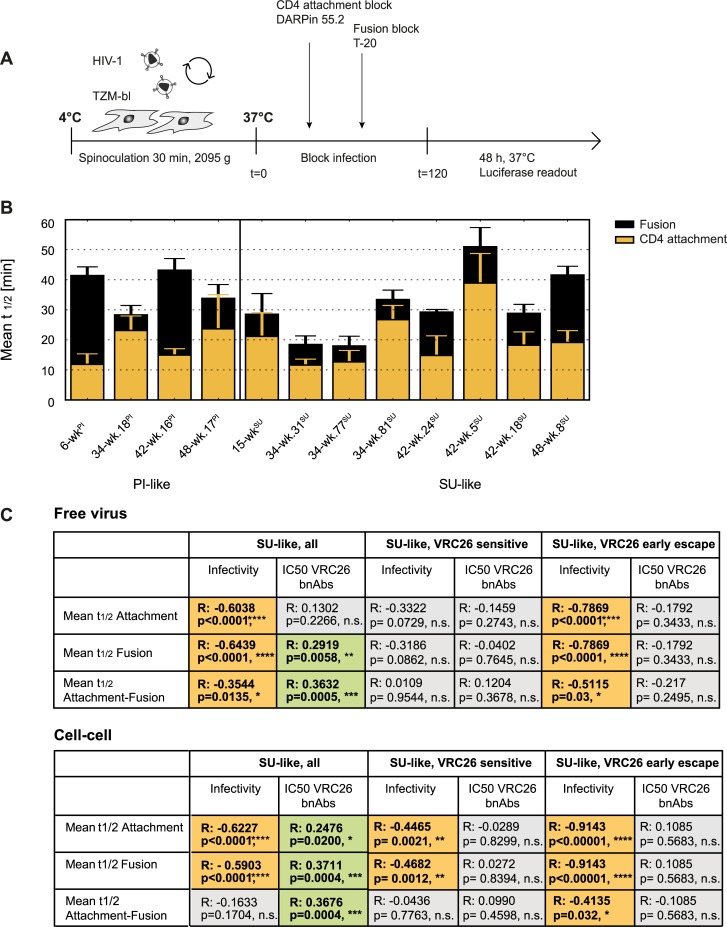
Virus evolution alters the entry kinetics of autologous CAP256 viruses.A: Schematic presentation of the free virus entry kinetic assay on TZM-bl target cells testing the half-maximal time to CD4-attachment and fusion. B: Mean half-maximal times of infection (t1/2) to CD4 attachment (orange) and virus fusion (black) of 2 to 4 independent experiments are displayed. C: Interrelations of IC50s (in μg/ml) for VRC26 bnAb neutralization, viral infectivity and mean half-maximal time (t1/2) to CD4-attachment, fusion and from CD4 attachment to fusion were determined for viruses analyzed in Fig 6B and displayed for all SU-like, SU-like VRC26 sensitive and SU-like VRC26 early escape viruses for both free virus and cell-cell transmission. Spearman correlation on untransformed data sets are shown with R and p values. Green fields denote positive, orange fields negative correlations. n.s. indicates no significance.